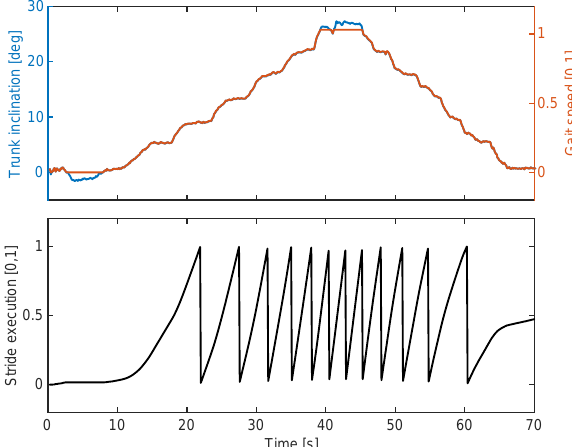
Figure 5. Experimental data from an SMM trial. Top panel shows in blue the trunk inclination in degrees acquired by a wireless inertial sensor during a 70-s experiment. The red line depicts the simultaneous gait speed in km/h, calculated using Equation (2). Bottom panel depicts the stride execution, i.e., the relative phase of movement of the mobile platform when executing one